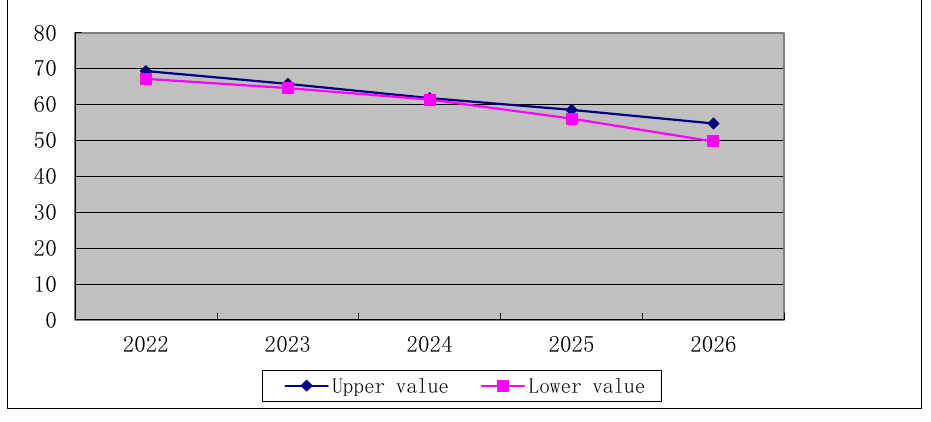
Figure 15. The variation interval of water requirement with the influence of secondary industry in Shanxi Province.